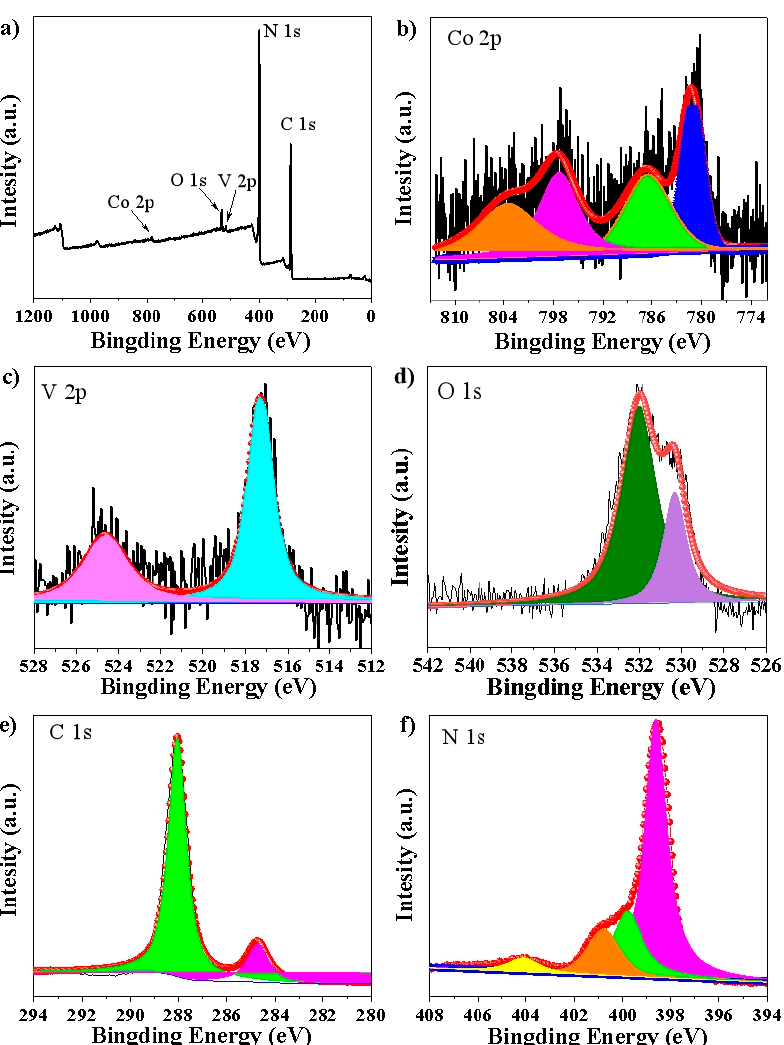
Figure 3. High-resolution XPS spectra of 3 wt % CoVO/PCN samples ( a ) survey; ( b ) Co 2p; ( c ) V 2p; ( d ) O 1s; ( e ) C 1s; ( f ) N 1s.